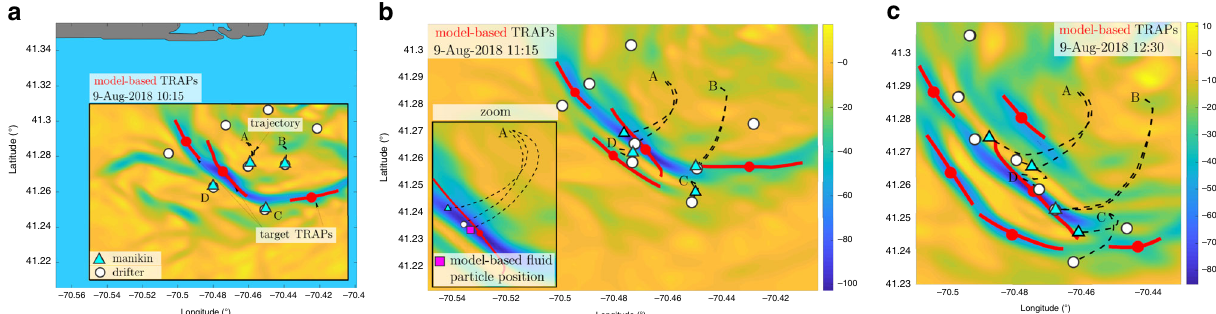
Fig. 6 2018 experiment. a Deployed drifters and manikins on the 9th of August 2018 based on TRAPs computed from the 24h forecast model velocity provided on the 8th at 8 pm. White dots and cyan triangles show the GPS-tracked location of CODE drifters and manikins (Fig. 3) at 10:15 am of the 9th August 2018. Dashed lines show object trajectories released at locations A – D from their deployment to the current time. b and c Drifter and manikin positions at later times, along with the corresponding model-based TRAPs. The inset in b shows a zoomed version of the manikin and drifter trajectories released in A, along with the trajectory of a fl uid particle (magenta square) obtained by integrating the model velocity from the same initial condition of the drifter and manikin. The unit of s 1 is day − 1 .